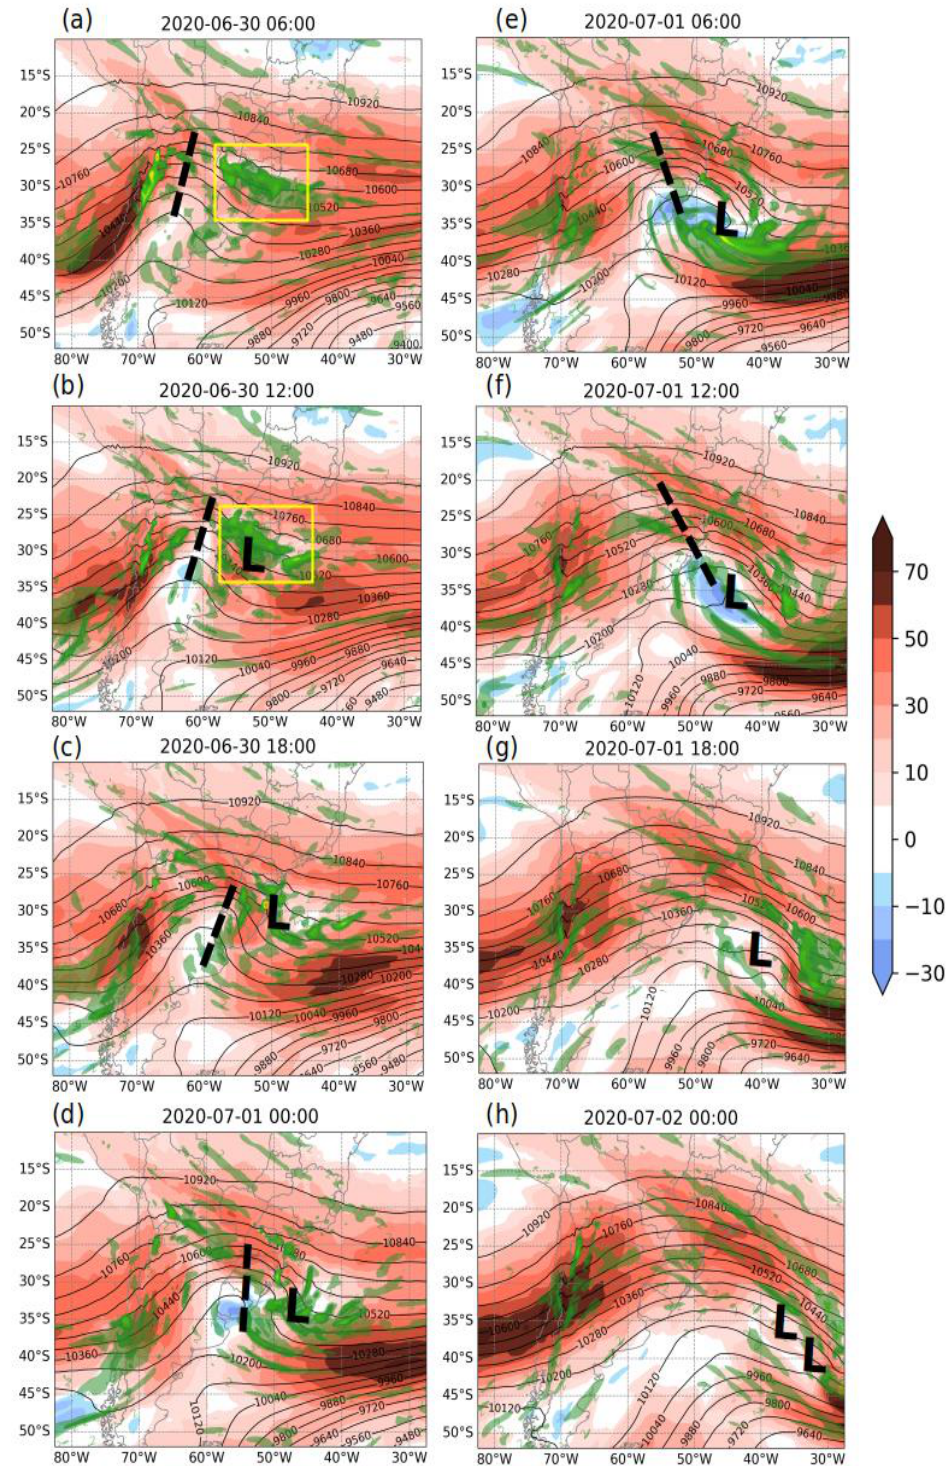
Figure 4. Vertical wind shear between 850 – 250 hPa (m s −1 ; shaded), geopotential height (m; black lines) at 250 hPa, and mass divergence at 250 hPa greater than (2 × 10 −5 s −1 , shades of green) from ERA5 ( a – h ). The letter L indicates the low position based on MSLP, the bold dashed line indicates the trough location, and the yellow boxes indicate regions of mass divergence.